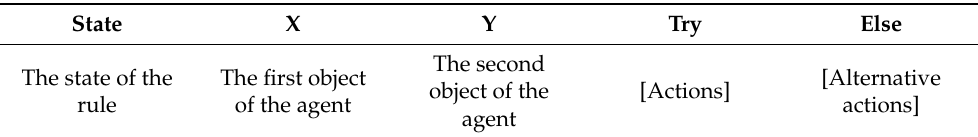
Table 1. The structure of the file of the rules of the agents. State